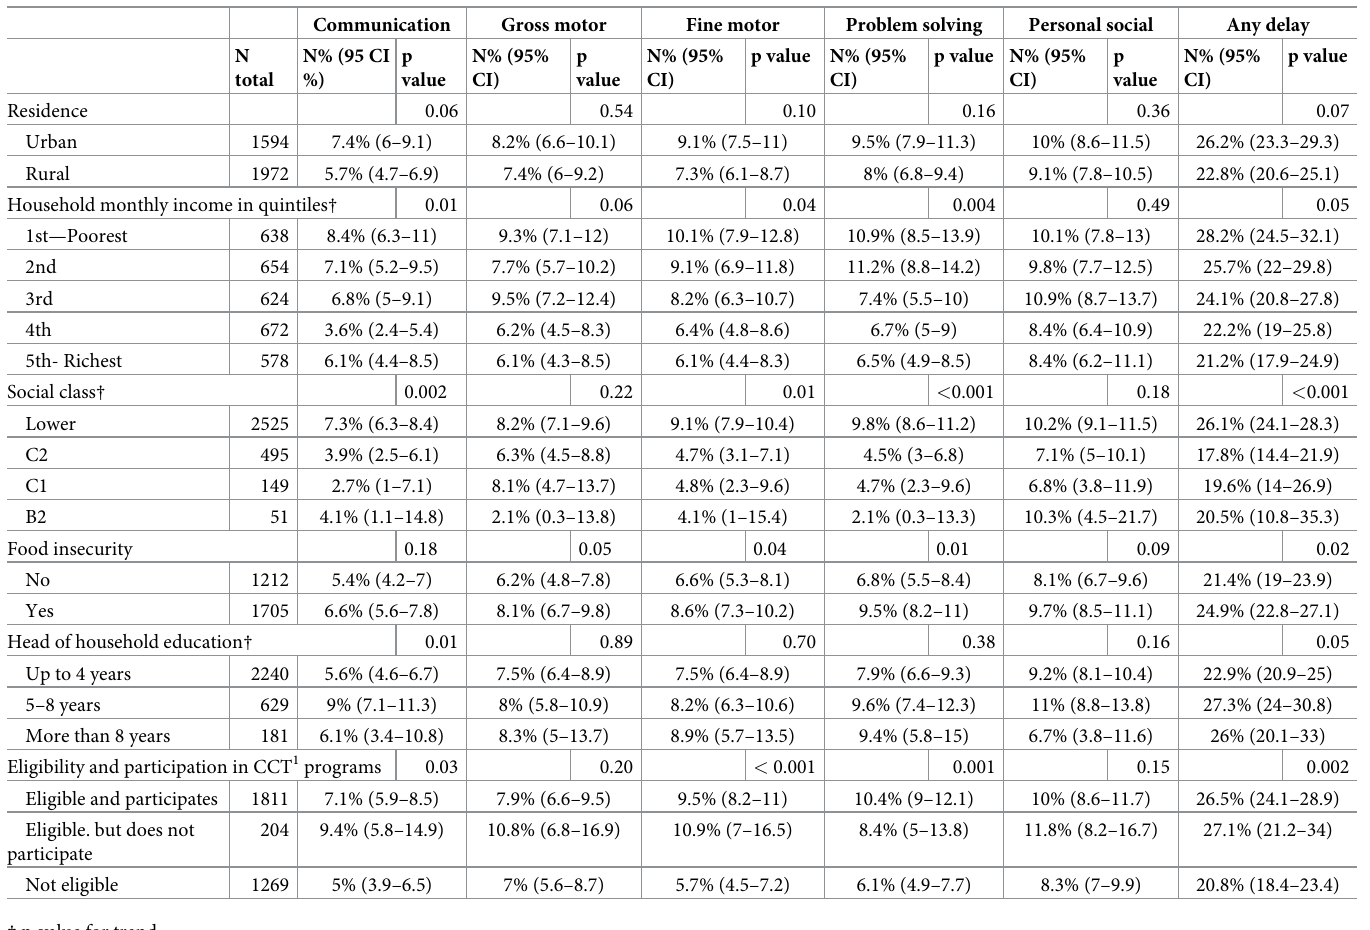
Table 5. Prevalence of risk of child development delay by domain stratified by socioeconomic factors.